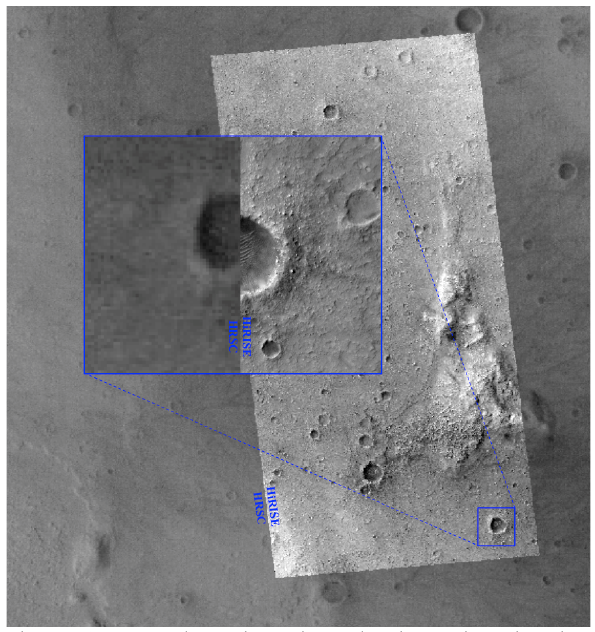
Figure 1. Example swipe view showing mis-registration between MER-A HiRISE ORI and HRSC ORI We projected the CTX and HiRISE ORI/DTM from Mars 2000 aerographic coordinate system into the Sinusoidal projection system with the same central meridian value, which is originally used in HRSC datasets, i.e. 176ºE for MER-A, 354ºE for MER- B, and 138ºE for MSL. The co-registration method applied is illustrated schematically in Fig.2.